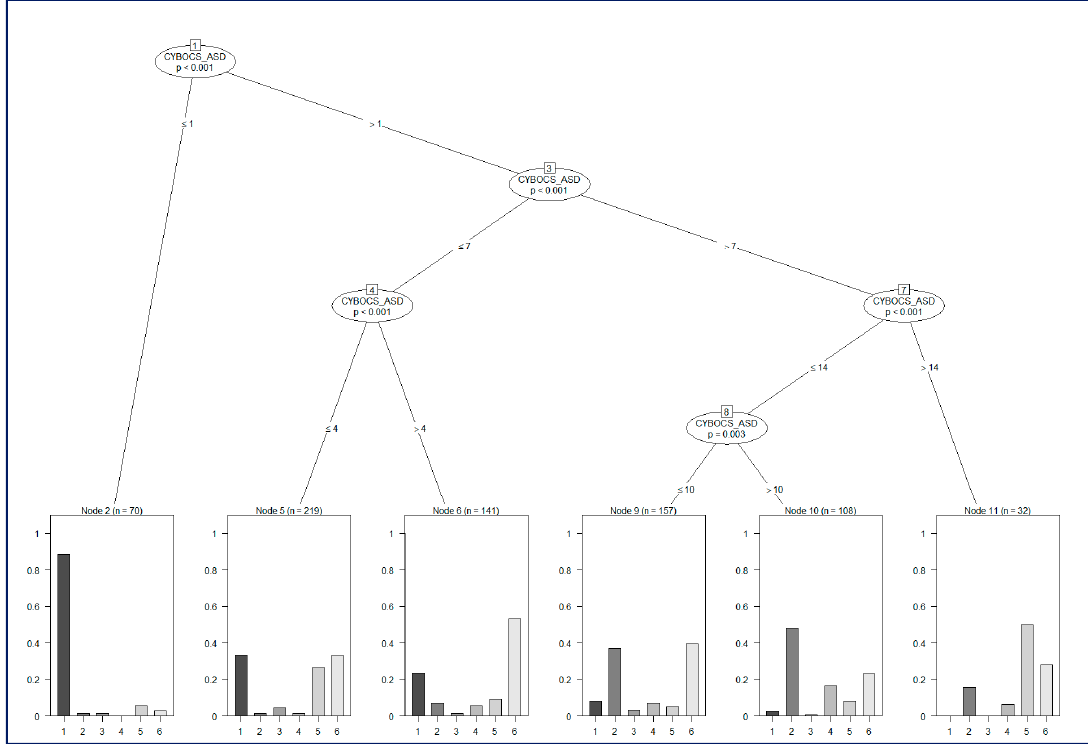
Figure 3. Decision tree. Clinical groups: 1: pure GTS; 2: GTS + OCD; 3: GTS + ADHD; 4: GTS + ADHD + OCD; 5: GTS + ASD; 6 ASD.